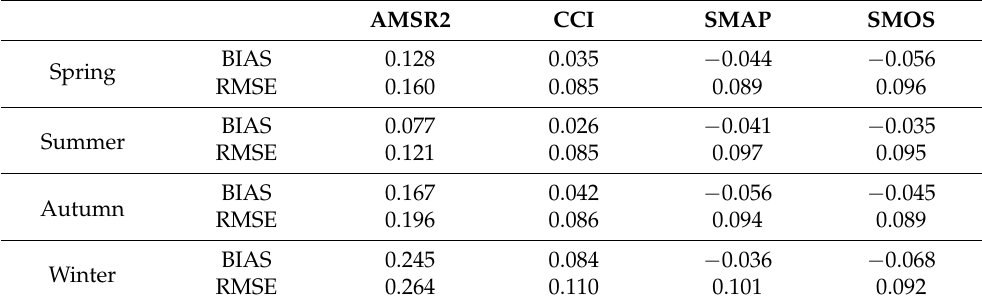
Table 2. Retrieval deviations of soil moisture products in different seasons (Unit: m 3 · m − 3